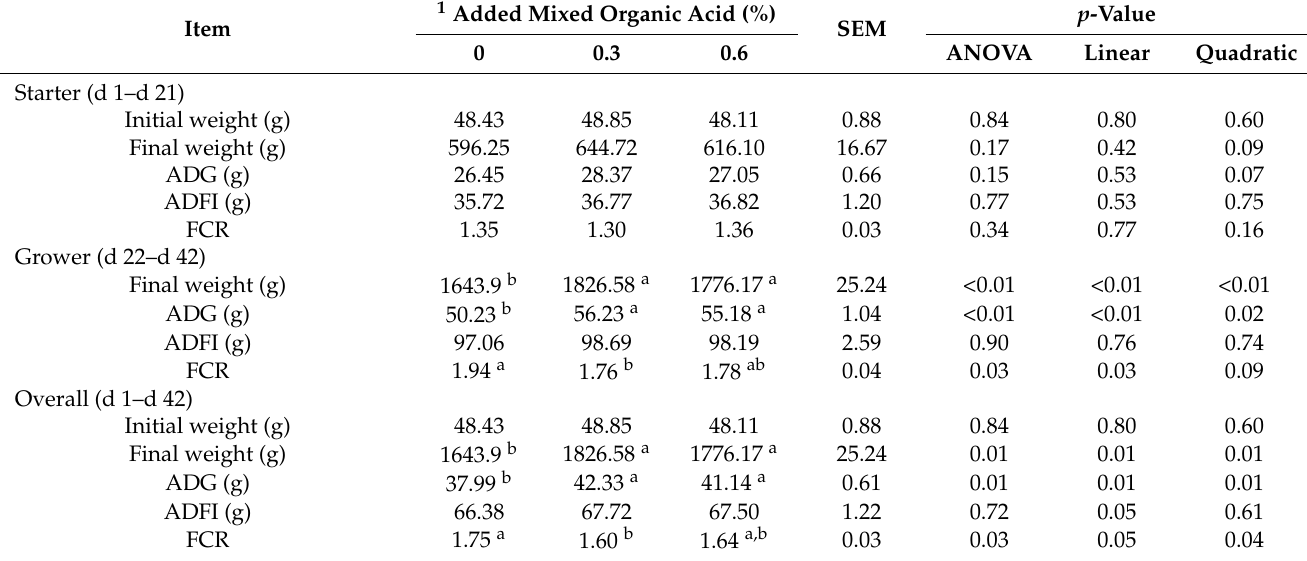
Table 2. Growth performance of broiler chickens as affected by dietary MOA supplementation.